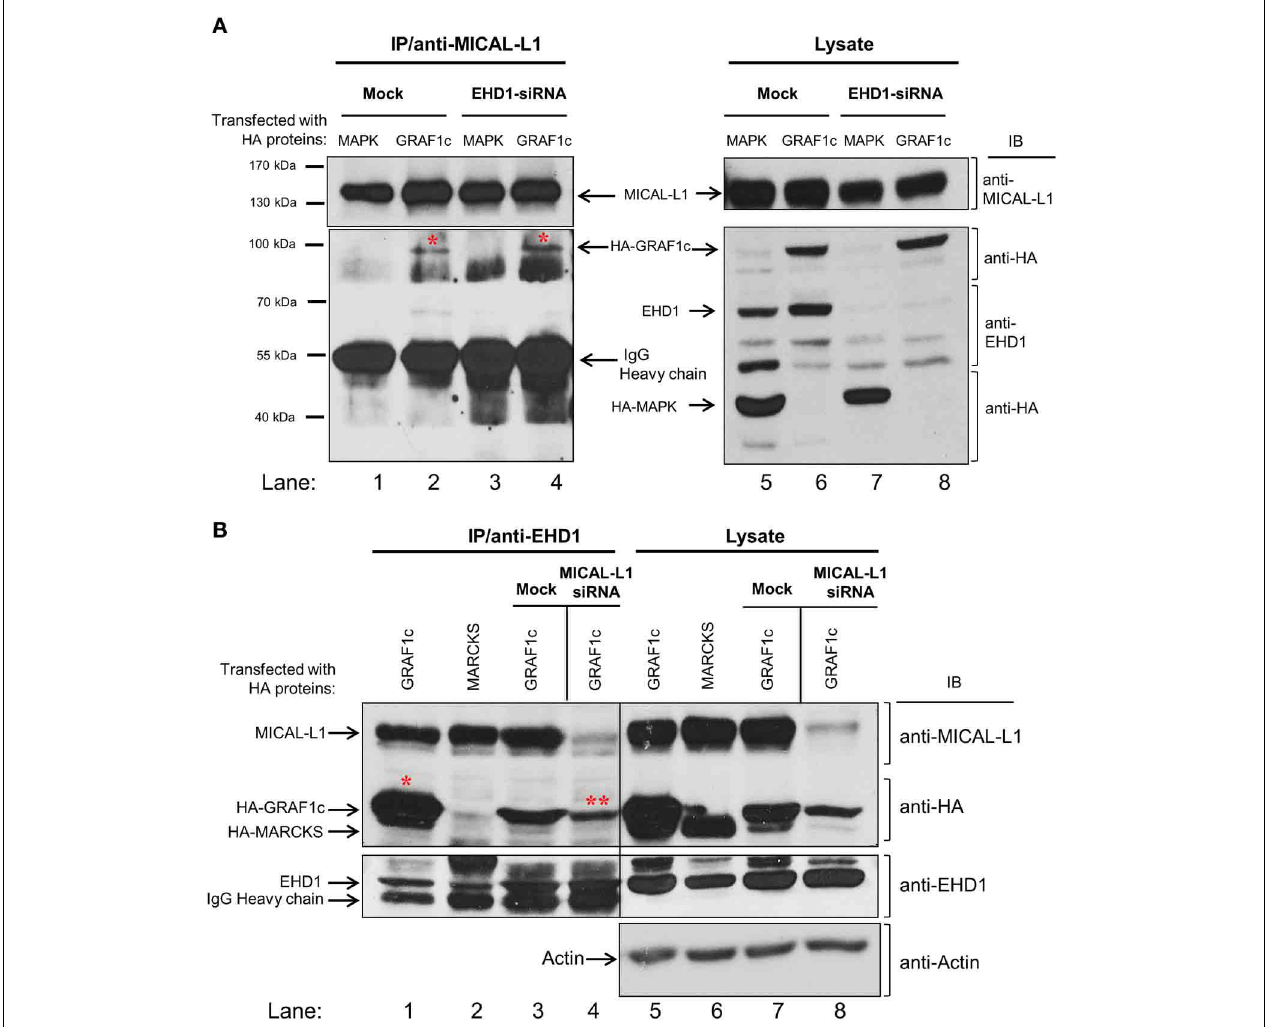
FIGURE 2 | GRAF1c, MICAL-L1, and EHD1 reside in a common complex. (A) HeLa cells were either mock-treated or treated with EHD1-siRNA for 72h. In the final 48h of the siRNA treatment, cells were transfected with either HA-MAPK (negative control) or HA-GRAF1c. Cells were then lysed with 0.5% Triton X-100 (right panel shows input). Lysates (left panel) were incubated with anti-MICAL-L1 antibody. Protein L beads were added to pull-down MICAL-L1 antibody and elution was done by adding SDS loading buffer. Samples were subjected to 8% SDS-PAGE, followed by blotting with